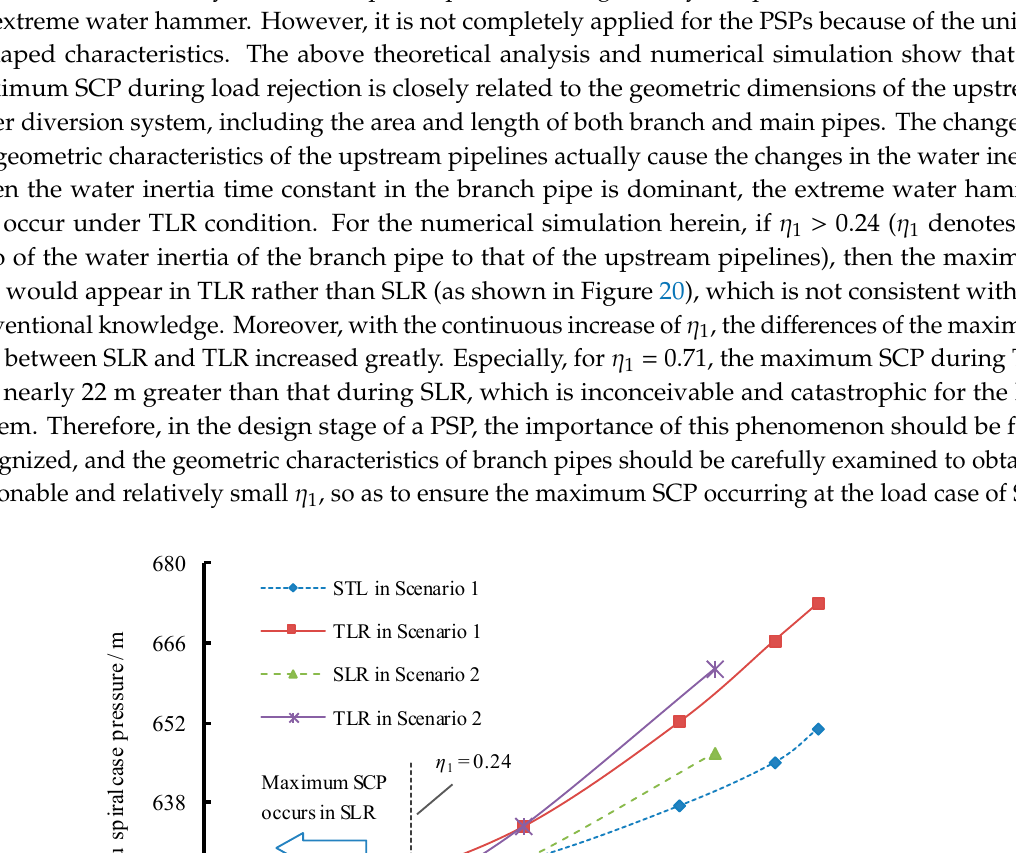
Figure 20. Variation of maximum SCP with η 1.